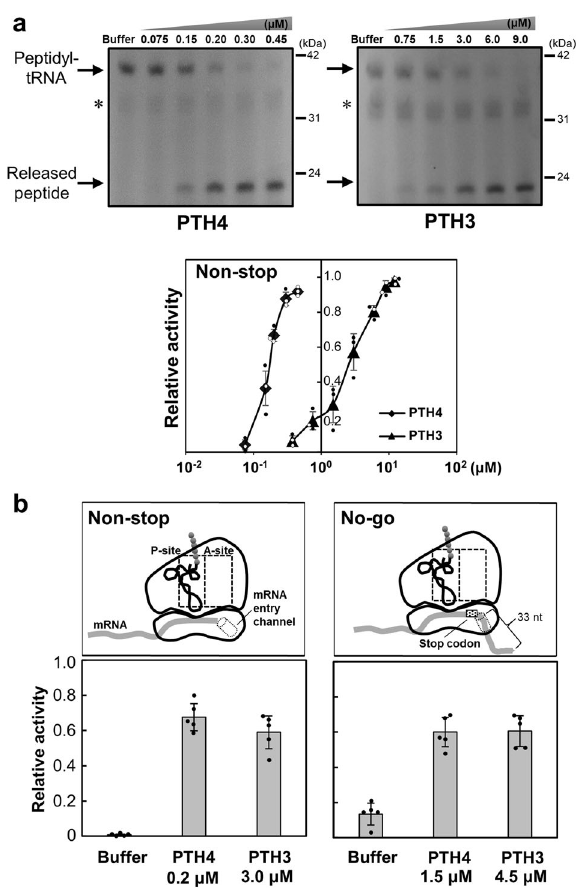
Fig. 5 PTH activities of Pth4 and Pth3 toward non-stop or no-go ribosomes using the E. coli -based reconstituted translation system. a In vitro translation of the non-stop template with recombinant His-tagged Pth4 and Pth3 proteins. Each recombinant protein was added to the solution in which a 15-min in vitro translation reaction had been performed using the non-stop templates. The resulting mixture, incubated for 5 min, was analyzed by NuPAGE, shown in the left panel. Each gel was visualized using a laser-based fl uorescent gel scanner. Released peptides and peptidyl-tRNA indicate Crp proteins and Crp-tRNA, respectively. The fi nal concentration of each recombinant protein is shown in each lane. An asterisk indicates a background band ( ≈ 30 kDa) that appears without the addition of template DNA or mRNA, as previously shown in the manufacturer ’ s technical note. The right panel shows the extent of peptidyl- tRNA hydrolysis (relative PTH activity) given as the ratio of the band intensity of released peptides to that of peptidyl-tRNA plus that of released peptides at the protein concentrations indicated. Data are shown as the mean ± standard deviation of three independent experiments. b Comparison of concentrations between Pth4 and Pth3 proteins required for similar PTH activities toward non-stop or no-go ribosomes. Each upper panels show a schematic drawing of a ribosome stalled on non-stop or no- go mRNA. The lower panels show that ≈ 60% PTH activities for non-stop and no-go ribosomes require the indicated concentrations of Pth4 or Pth3. Data are shown as the mean ± standard deviation of fi ve independent experiments. An example of gel images is shown in Supplementary Fig.